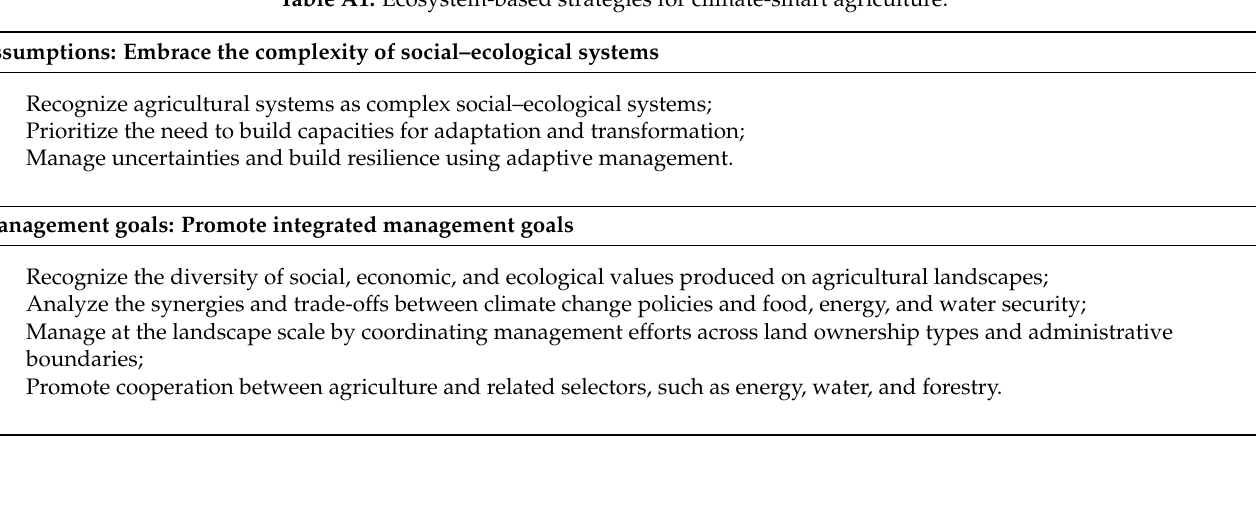
Table A1. Ecosystem-based strategies for climate-smart